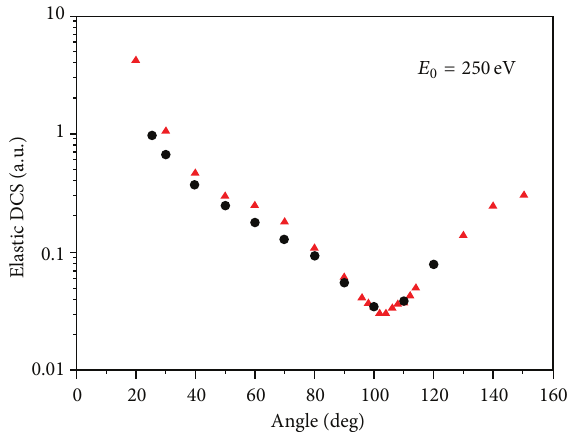
Figure 14: Present results ( ∙ ) of elastic DCS of Ar in comparison with the data of Williams and Willis ( ) [37].